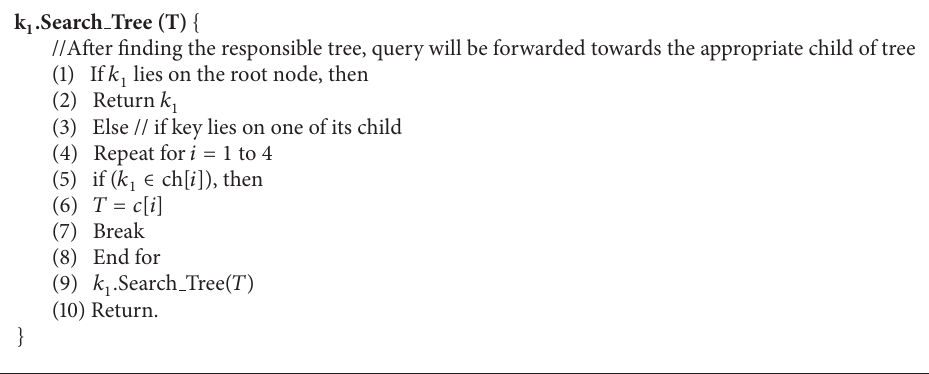
Algorithm 6: Key lookup operation in the responsible tree of the proposed